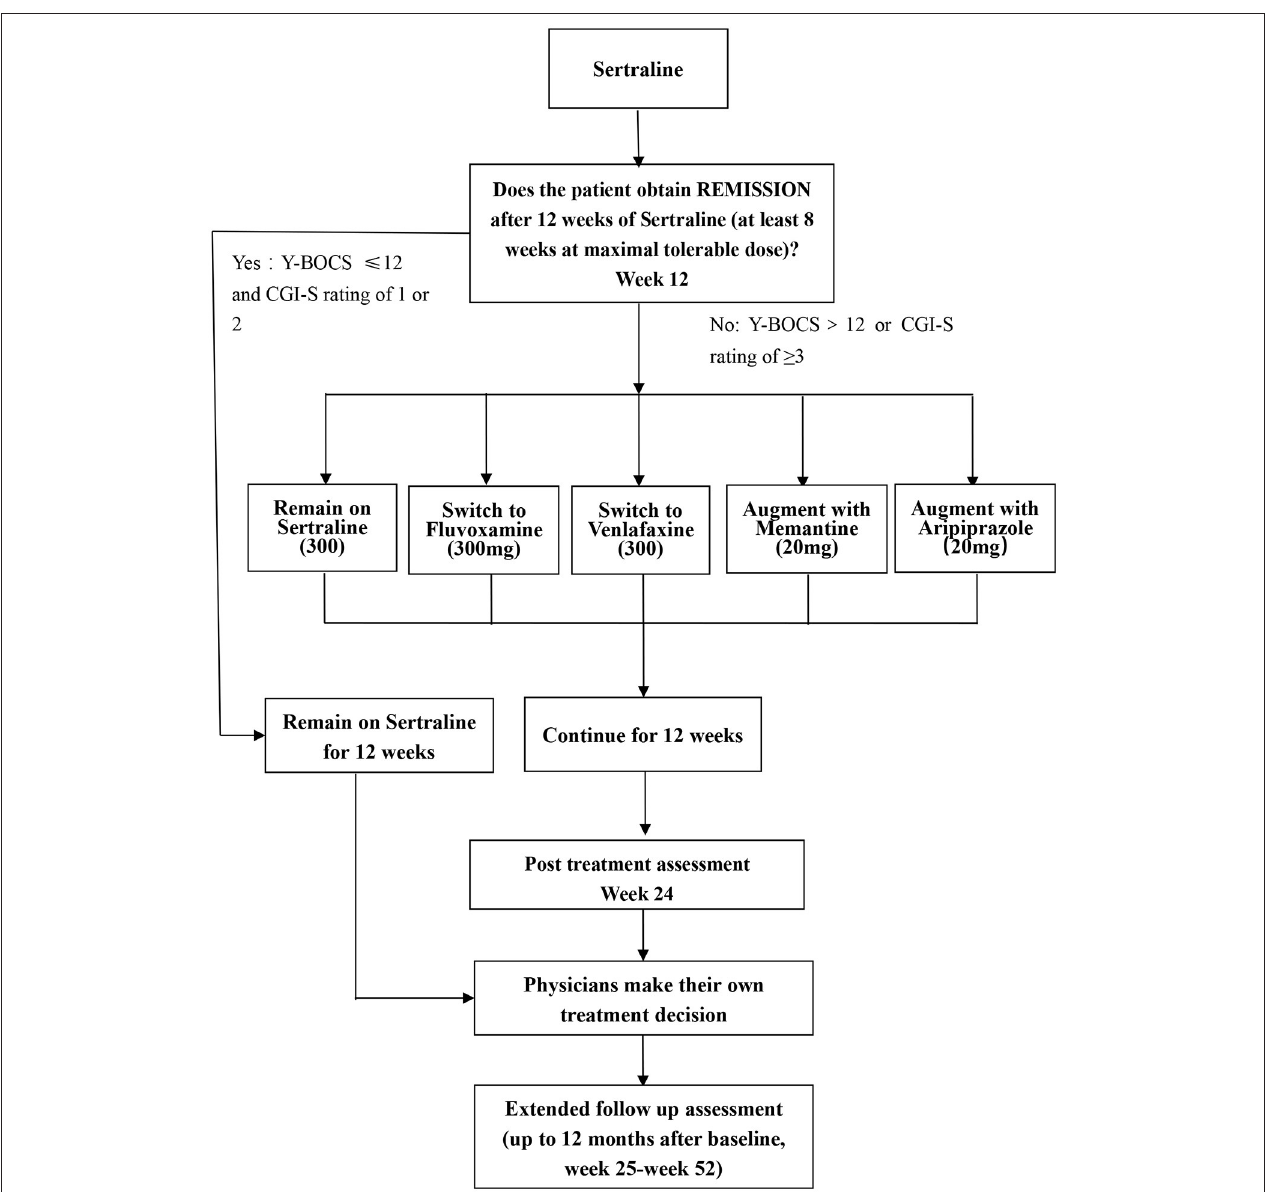
FIGURE 1 | Flow chart of this study. Y-BOCS, Yale-Brown Obsessive Compulsive Scale; CGI, clinical global impression.